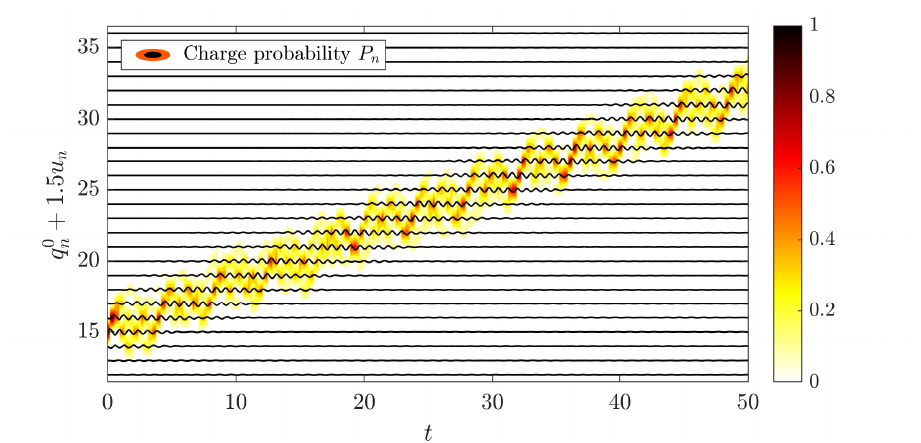
Figure 1. Charge transfer by a mobile discrete breather in the model example of Section 2.7. Solid lines indicate the lattice particle displacements amplified by the factor 1.5, while the color plot illustrates the probability of finding the charge at a lattice site at a given time. Numerical results are obtained with the explicit, symplecticity-preserving, symmetric numerical method PQDABADQP, see Section 4.3. See also Section 5 for additional numerical results of charge transfer by discrete